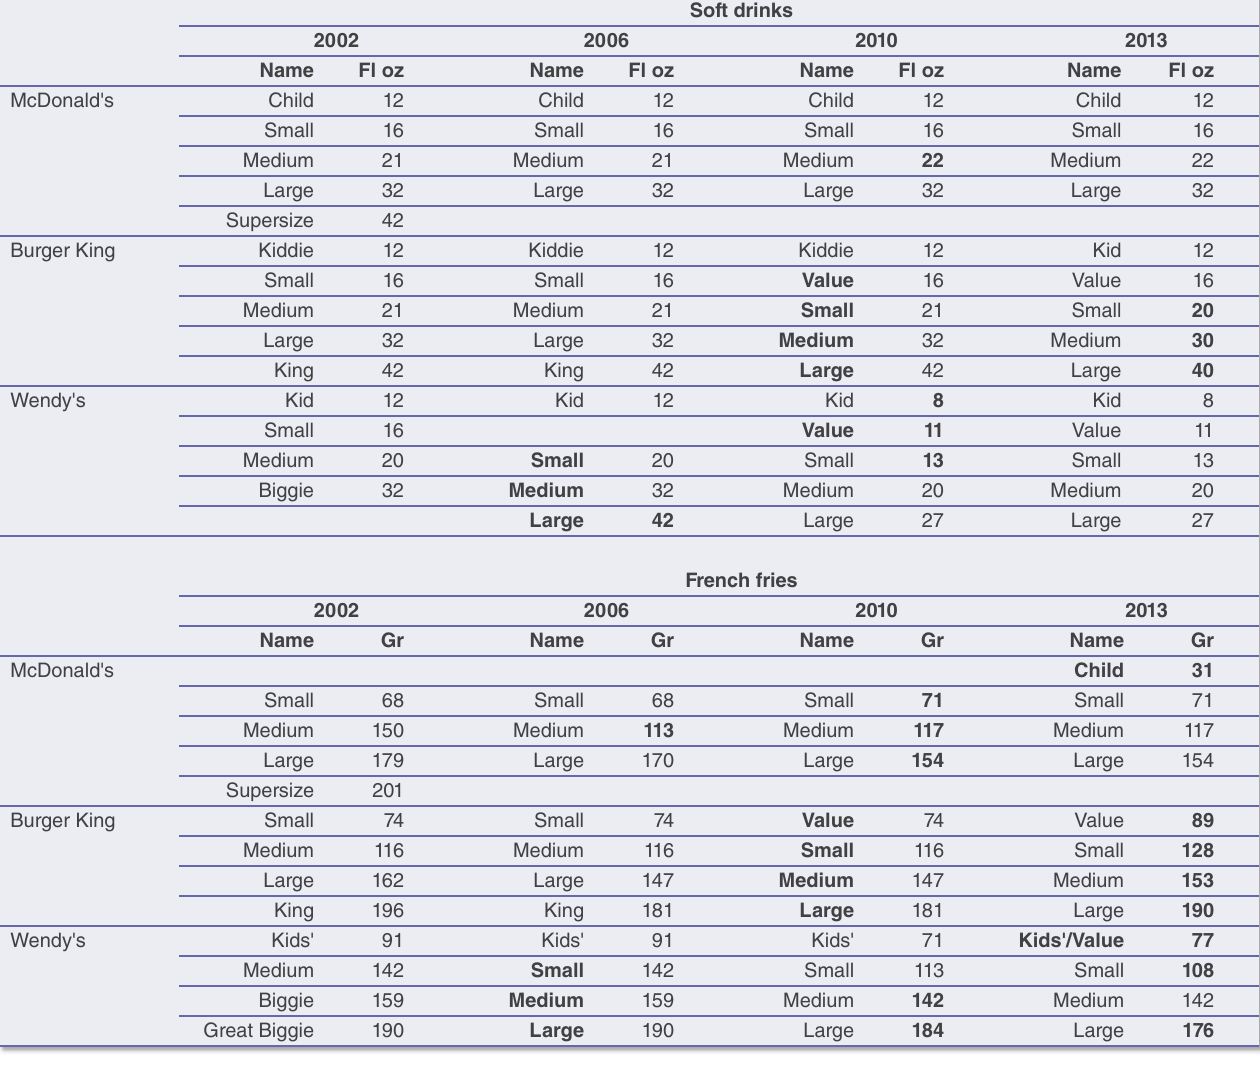
Table 16. Changes in sizes of soft drinks and french